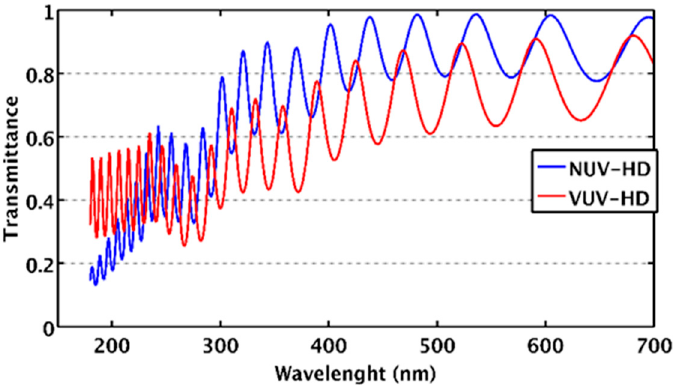
Figure 24. Calculated transmittance in silicon of normal incident light on the NUV-HD ARC (blue line) and on the modified ARC of VUV-HD SiPMs.